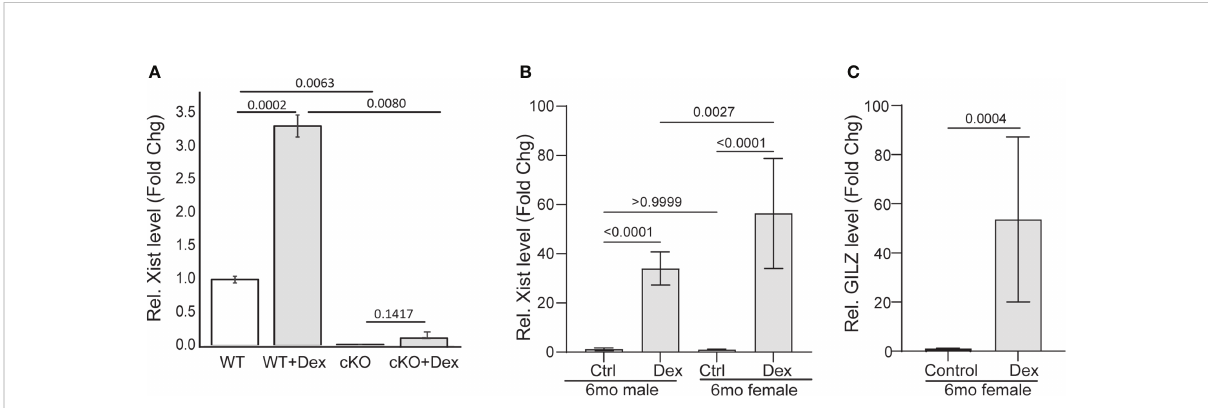
FIGURE 5 Xist RNA is induced by GCs. (A) qRT-PCR showing Dex induction of Xist in GR- fl ox and GR cKO MSCs. (B, C) qRT-PCR showing Dex induction of Xist (B) and GILZ (C) in mice (6-mo-old C57BL/6 mice). Results are from 2 (control) or 3 (treatment) individual mice. PCR reactions were performed in triplicates. One-way ANOVA or t -test, p values are indicated.